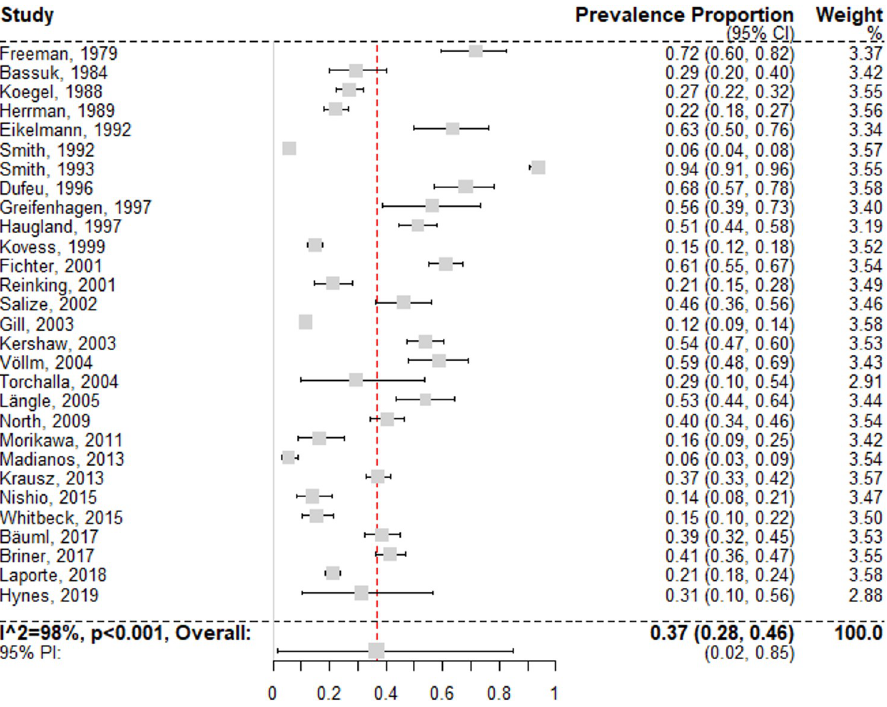
Fig 6. Forest plot of prevalence estimates of alcohol use disorders. AU : Basedonthereferenceslist ; IbelievethefollowingareerrorsinFig 6 : ð 1 Þ Gill ; 1996 shouldbeGill ; 2003 ½ 66 �ð 2 Þ Kershaw ; 2000 shouldbeKershaw ; 2003 ½ 61 �ð 3 Þ LaPorteshouldbeLaporte ½ 29 �ð 4 Þ Hynes ; 2018 shouldbeHynes ; 2019 ½ 62 � PleasefixtheseerrorsinFig 6 : Asecond (cid:0) bestsolutionwouldbetoequatethesemisidentifiedrefswiththeircorrectreferencenumbersinthefigurelegend Analytic weights are from random effects meta- analysis. Grey boxes represent study estimates; their size is proportional to the respective analytical weight. Lines through the boxes represent the 95% CIs around the study estimates. The blue diamond represents the mean estimate and its 95% CI. The vertical red dashed line indicates the mean estimate. CI, confidence interval; PI, prediction interval; RE, random